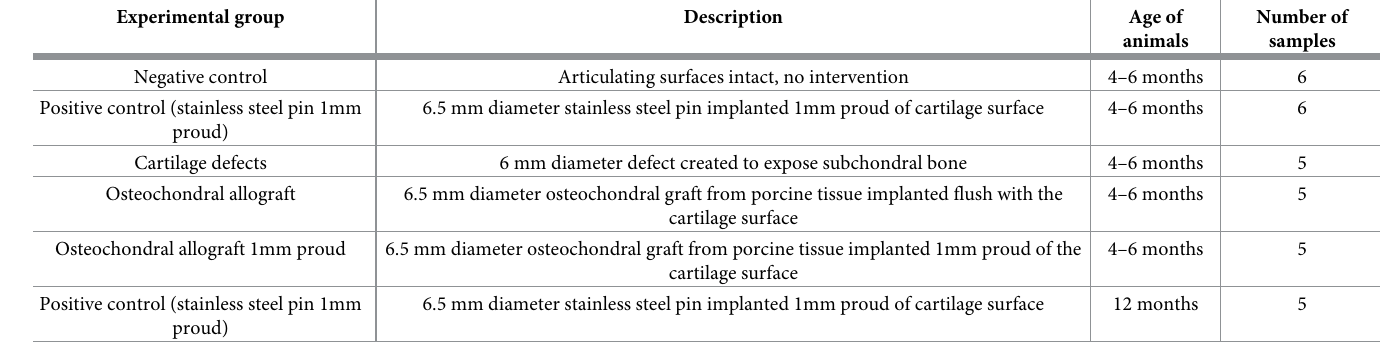
Table 1. The experimental groups investigated, all groups were studied for 3 hours of simulation at 1Hz (10,800 cycles) in a single station knee simulator. Experimental